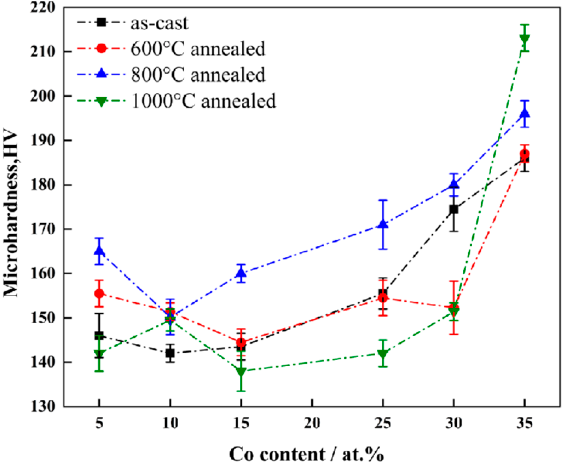
Figure 6. Microhardness of the as-cast and annealed Co x CrFeMnNi 2 − x